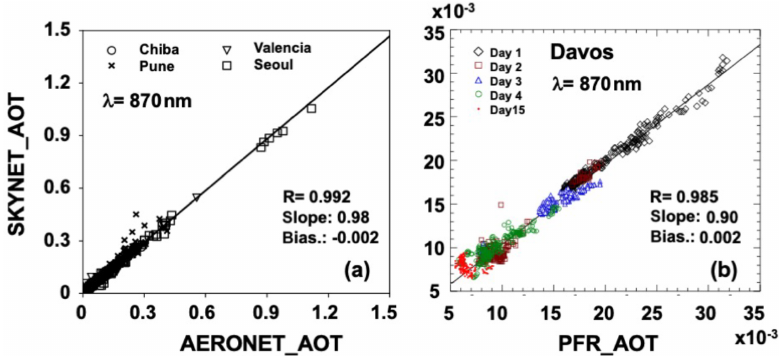
Figure 8. Comparison of AOT values at λ = 870nm obtained by the sky radiometer, Cimel sun photometer, and PMOD PFR. Table 5. Statistics of AOT differences from other networks. RMSD values of Estellés et al. (2012) are differences between AERONET values and SUNRAD values for the same Cimel-CE318 sun photometer data with mode 1 (SKYNET-like) and mode 2 (AERONET-like)